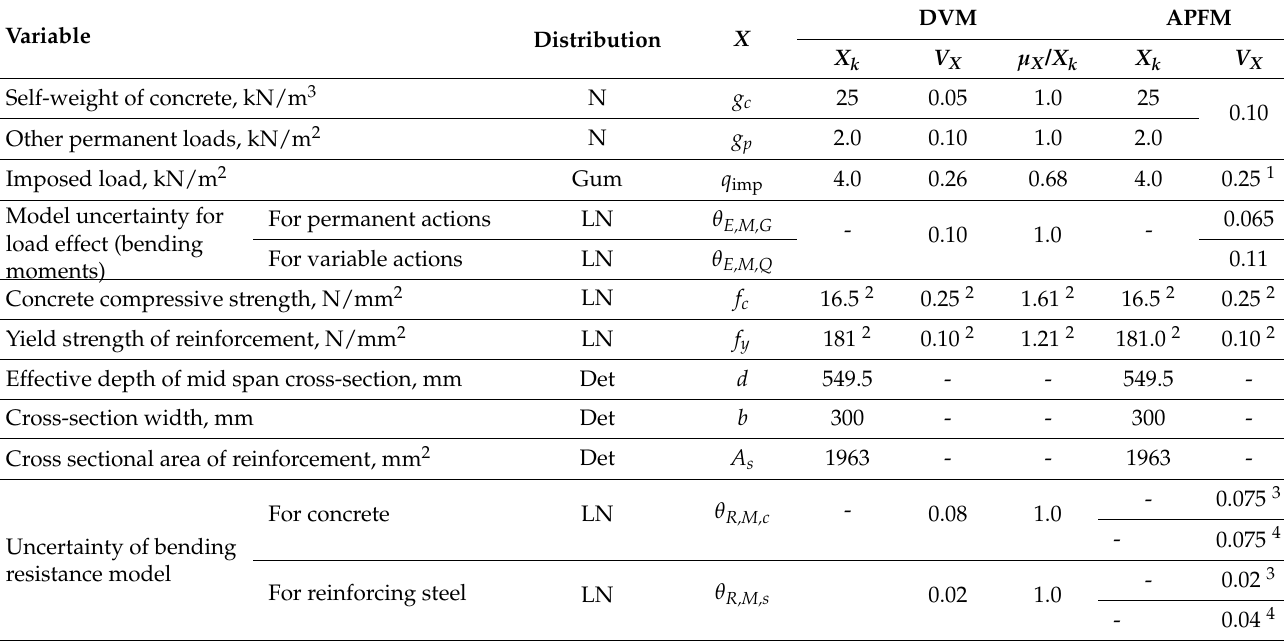
Table 4. First stage probabilistic models for basic variables adopted for the assessment according to fib Bulletin 80 [10].